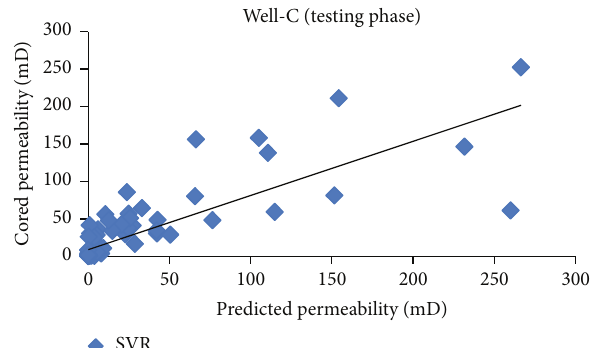
Figure 16: Cross plot of cored and predicted permeability for SVR model.